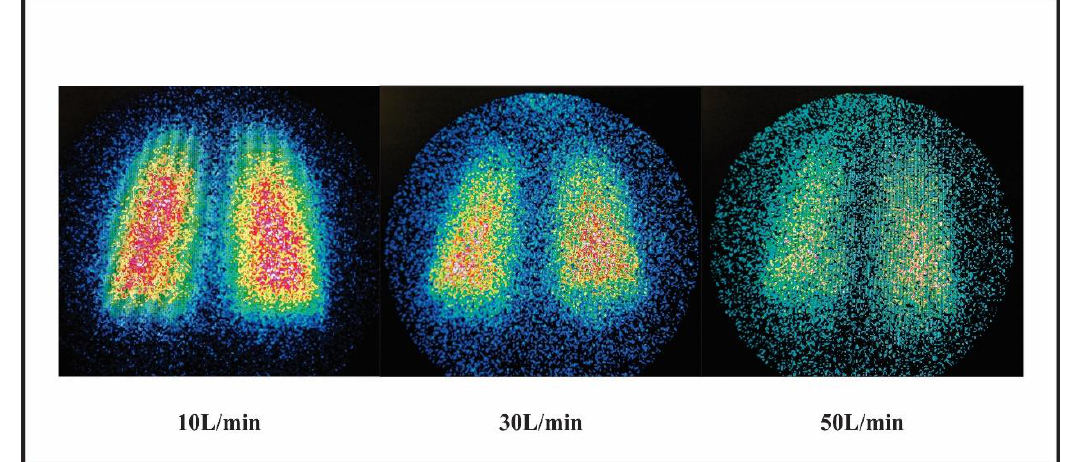
Figure 3. Representative images of pulmonary deposition with heated humidified LFNC at 10 L/min and HFNC at 30 L/min and 50 L/min.